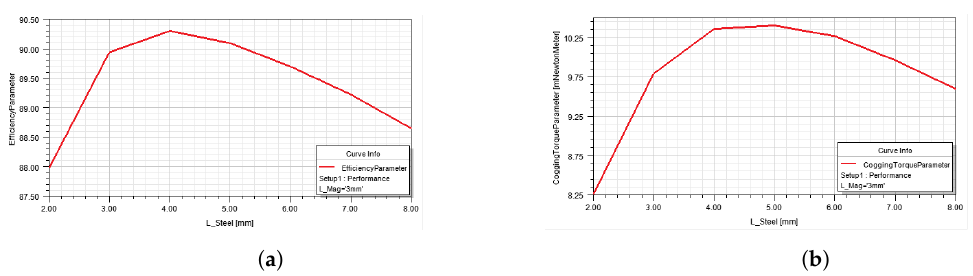
Figure 11. ( a ) Efficiency and ( b ) Cogging torque depending on the rotor steel sheet’s thickness.